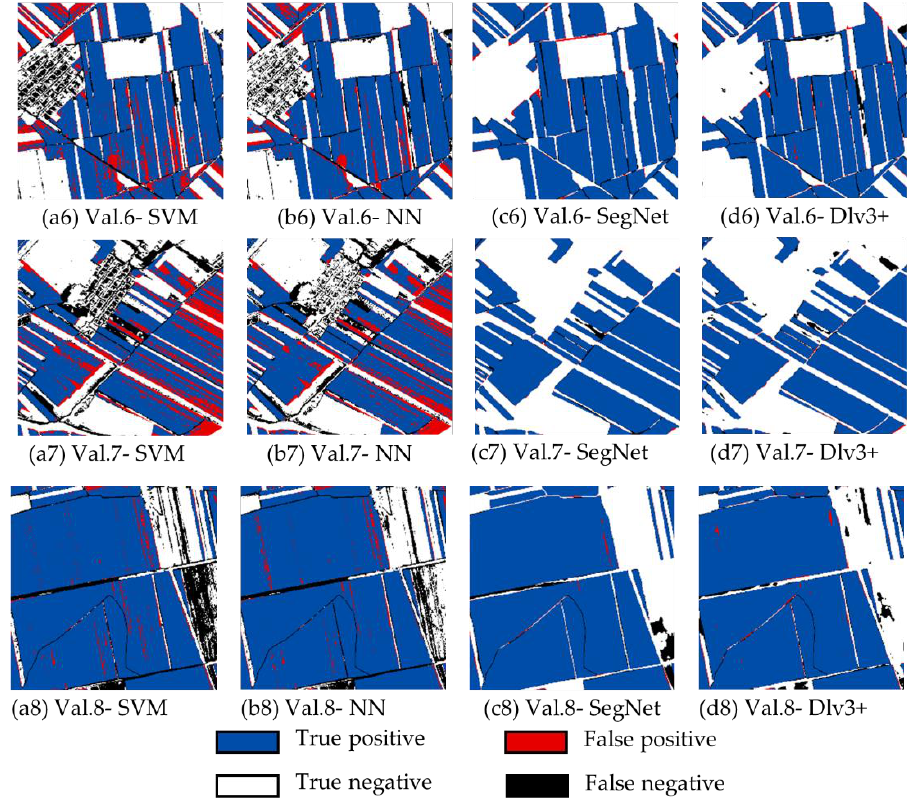
Figure 8. Classification maps for SVM, NN, SegNet, and Dlv3+ on eight validation samples.